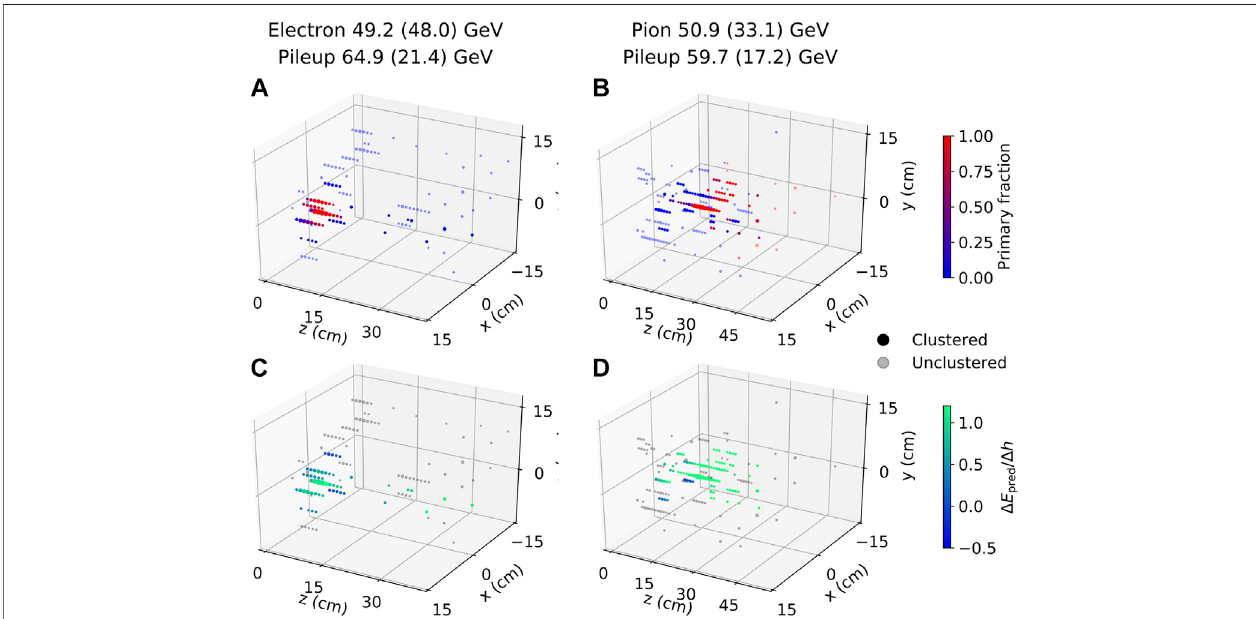
FIGURE 3 | Examples of electron (A) , (C) and pion (B) , (D) events. Values in parentheses in the graph titles are the respective energy depositions contained in the cluster around the seed hit. Points represent hits in the detector, with their coordinates at the center of the corresponding detector cells and the size of the markers proportional tothe square rootofthe hitenergy.Opaque points arewithinthe cluster,whilethetranslucent onesare not.In (A) and (B) ,thepoint colorscale fromblue to red corresponds to the primary fraction (see Section 5.1 for de fi nition). In (C) and (D) , the color scale from blue to green corresponds to Δ E pred / Δ h , which is an indication of the importance the neural network model places to individual hits for energy regression. See Section 5.3 for details.